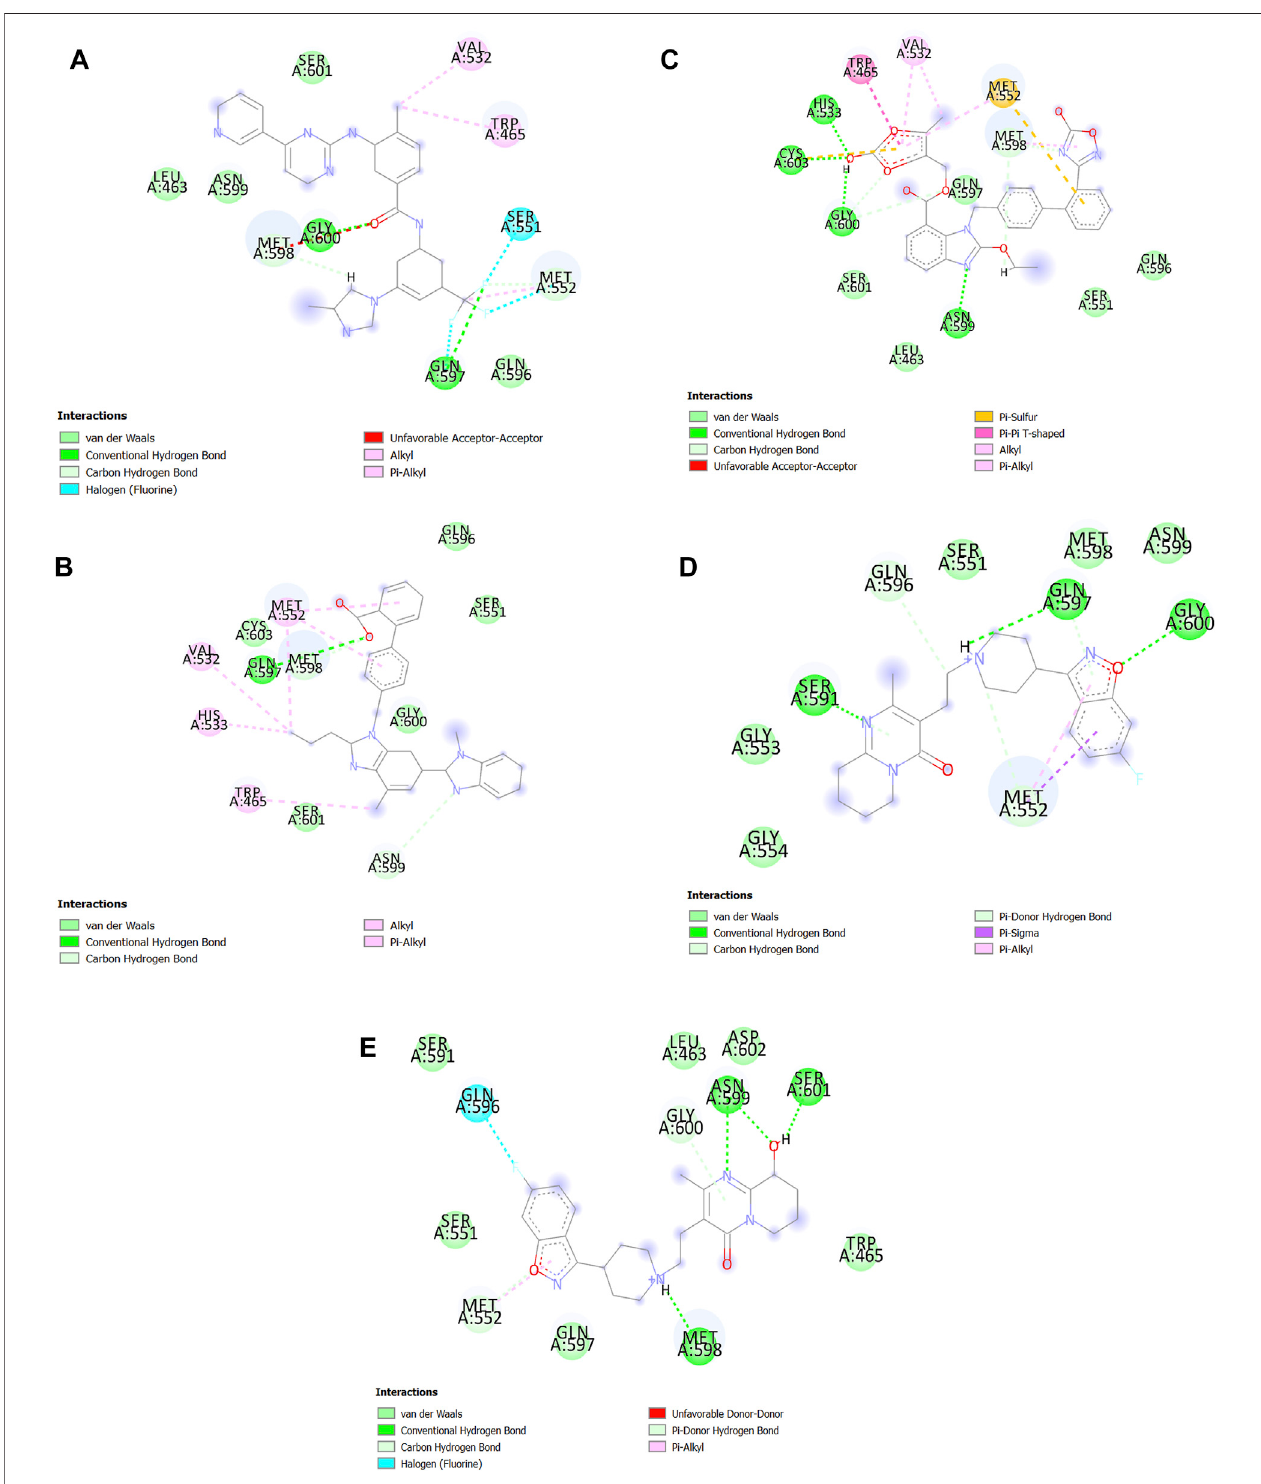
FIGURE 8 | 2D structure of the best drugs for SENP1 inhibition. (A) Nilotinib, (B) Telmisartan, (C) Azilsartan medoxomil, (D) Risperdal, and (E) Paliperidone.